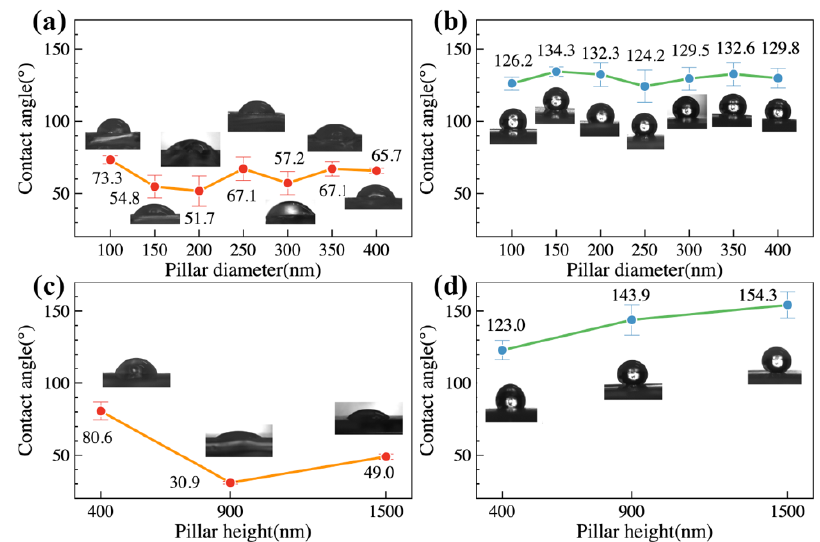
Figure 6. Water contact angle on the epoxy surface before and after modification: ( a ) Water contact angle on the pillar-structured epoxy with a pillar diameter in the range of 100–400 nm. The pillar heights are controlled by AAO templates with a pore depth of 500 nm. ( b ) Water contact angle on the pillar-structured F-epoxy (1 wt %) with a pillar diameter in the range of 100–400 nm. The pillar heights are controlled by AAO templates with a pore depth of 500 nm. ( c ) Water contact angle on the pillar-structure epoxy with a pillar height in the range of 400–1500 nm. The pillar diameters are controlled by AAO templates with a pore diameter of 300 nm, and the AAO templates control the pore distance of 450 nm. ( d ) Water contact angle on the pillar-structured F-epoxy (1 wt %) with a pillar height in the range of 400–1500 nm. Pillar diameter with a pore diameter of 300 nm and a pore distance of 450 nm.